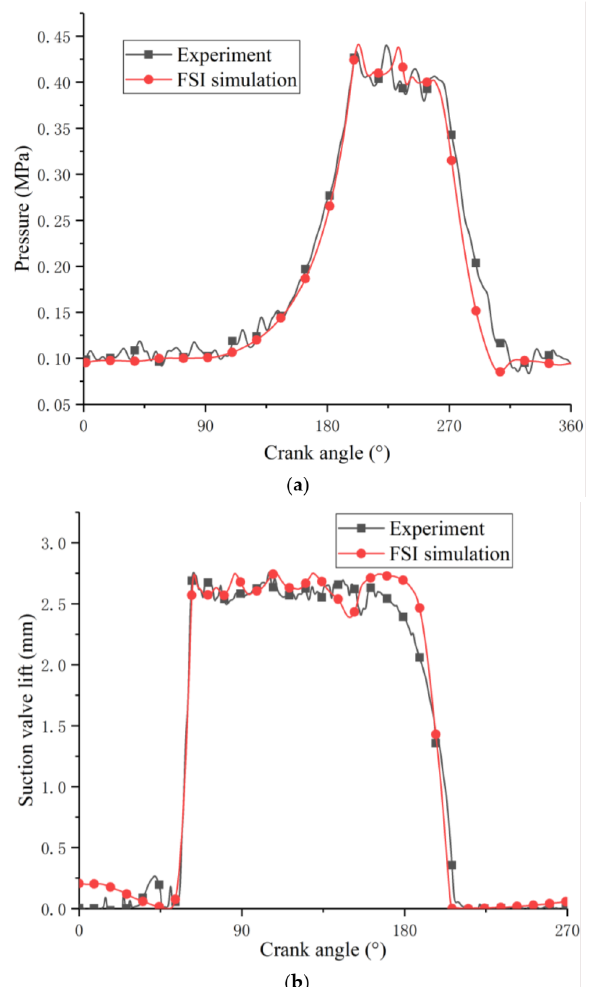
Figure 10. ( a ) The p- θ diagram in the experiment and FSI simulation. ( b ) The Movement of the suction valve in the experiment and FSI